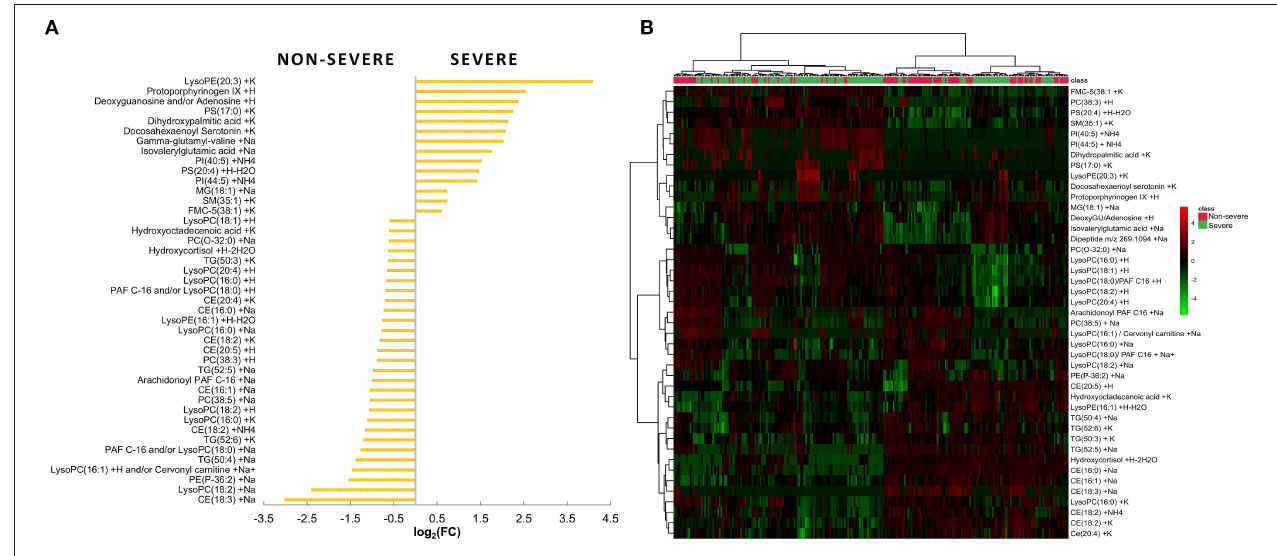
FIGURE 1 | (A) Bar plot reporting the fold-change values of the 43 relevant metabolites selected using a combined evaluation of p and FC (severe/non-severe comparison). (B) Hierarchical clustering heat map showing the abundance of the top 43 metabolites based on VIP scores of non-severe and severe